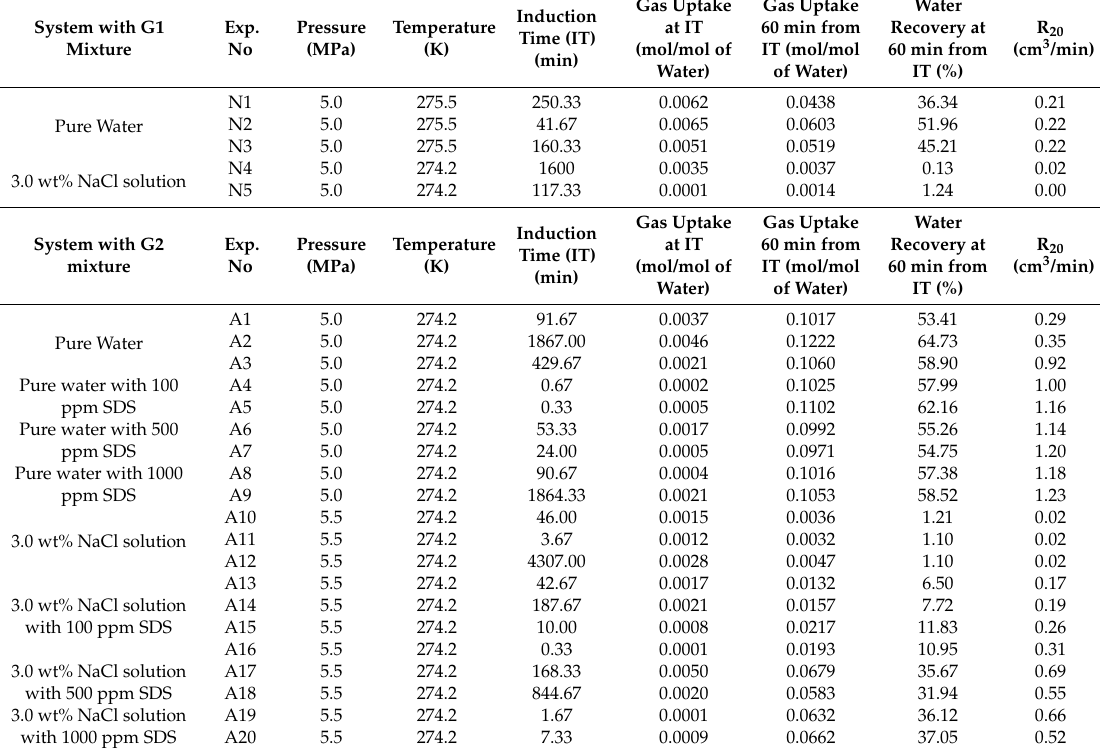
Table 2. Summary of experimental conditions and results with G1 (C 3 H 8 /N 2 (10 mol%/90 mol%)),